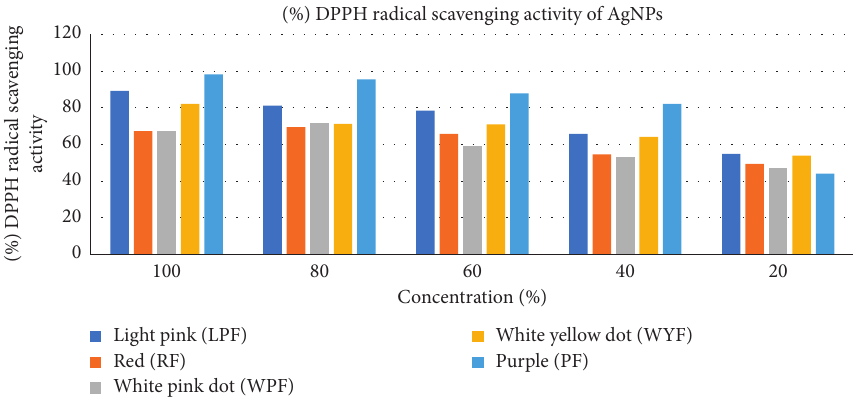
Figure 18: IC50 of the Table 4: IC50 of water extracts and AgNPs.